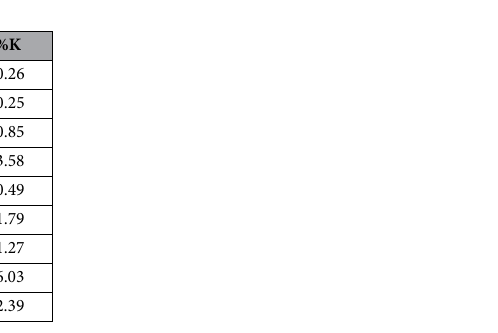
Figure 2. Relative variation of weight for the untreated and plasma treated seeds as a function of exposure time to water vapor for the indicated periods of time. Top) RF and bottom) DBD plasmas.